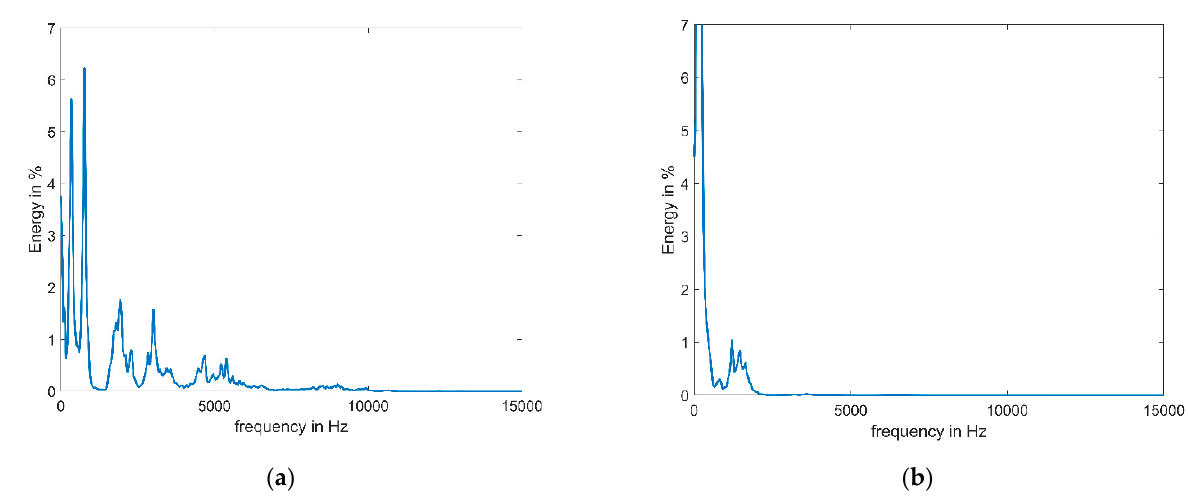
Figure 6. Averaged spectral energy of 10 squeals of pig 3 ( a ) before and ( b ) after surgery. Energy spectra were calculated using 1024 data point windows with 50% overlap. A distinct energy reduction at higher frequencies can be seen, resulting in lower PF and Q-parameters.